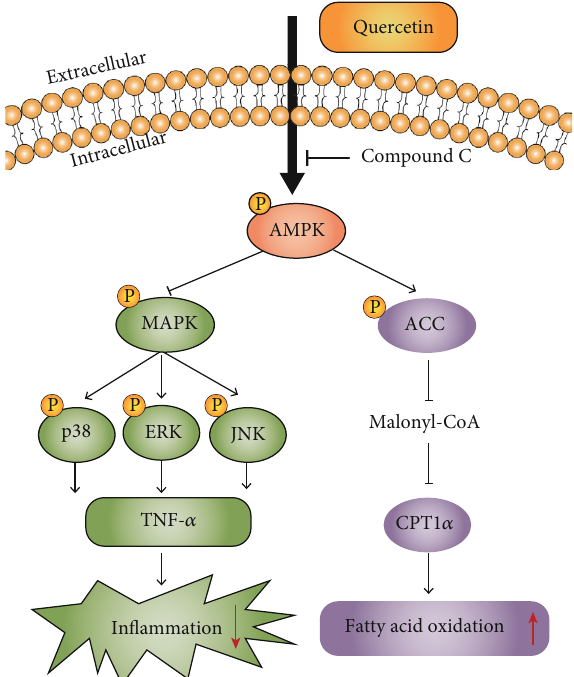
Figure 10: Quercetin exerts an anti-NAFLD e ff ect by regulating the AMPK/MAPK/TNF- α and AMPK/ACC/CPT1 α signaling pathways to inhibit in fl ammation and enhance fatty acid β - oxidation. Activation of AMPK by quercetin leads to downregulation of MAPK signaling pathways and decreases the expression of TNF- α , which may contribute to relieve in fl ammation. In addition, phospho-AMPK phosphorylates ACC, the rate-limiting enzyme of de novo lipogenesis. This decrease in ACC activity limits malonyl CoA production, relieving the inhibition of CPT-1 α activity and enhancing fatty acid β